Question: Summarize what this figure shows in one sentence.
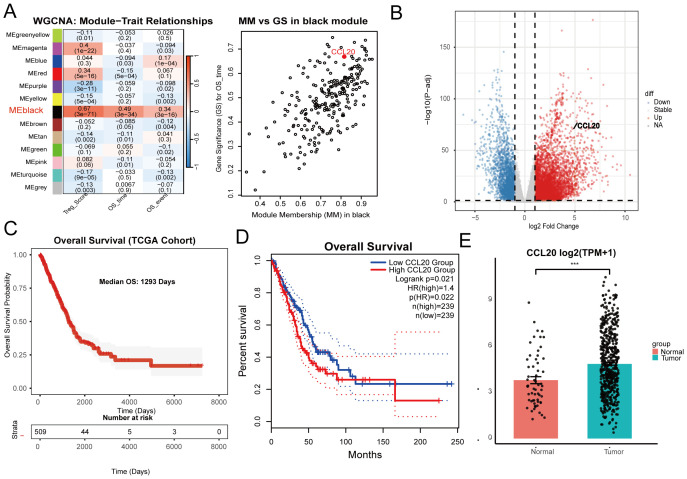
Answer: Expression profile and prognostic significance of CCL20 in the TCGA-LUAD cohort. (A) WGCNA Co-expression Network Analysis Identifies Key Modules and Hub Genes. Left: A heatmap illustrates the correlation between gene modules and clinical features (Treg score, survival status), revealing that the black module (MEblack) is highly correlated with Treg infiltration and survival events. Right: Scatter plot of module membership (MM) versus gene significance (GS) for genes within the MEblack module. CCL20 is identified as a top hub gene in this clinically relevant module. (B) Volcano Plot of Differentially Expressed Genes in TCGA-LUAD. The plot displays genes differentially expressed between lung adenocarcinoma tumor tissues and adjacent normal tissues. Upregulated and downregulated genes are shown in red and blue, respectively. CCL20 is highlighted as a significantly upregulated gene in tumors. (C) Baseline OS of the TCGA-LUAD Cohort. The Kaplan-Meier curve depicts the overall survival probability for the entire TCGA lung adenocarcinoma patient cohort included in this study. The median overall survival was 1293 days. (D) Kaplan-Meier Survival Analysis Based on CCL20 Expression Levels. Patients were stratified into high (cyan) and low (red) CCL20 expression groups. The CCL20 high-expression group showed a significantly worse overall survival rate compared to the low-expression group ( P = 0.0041), indicating that high CCL20 expression is a marker of poor prognosis. (E) Quantitative Comparison of CCL20 Expression between Tumor and Normal Tissues. A boxplot with overlaid scatter points demonstrates that the expression level of CCL20 (log2 TPM + 1) is significantly elevated in lung adenocarcinoma tumor tissues (Tumor) compared to normal lung tissues (Normal). *** P < 0.001.